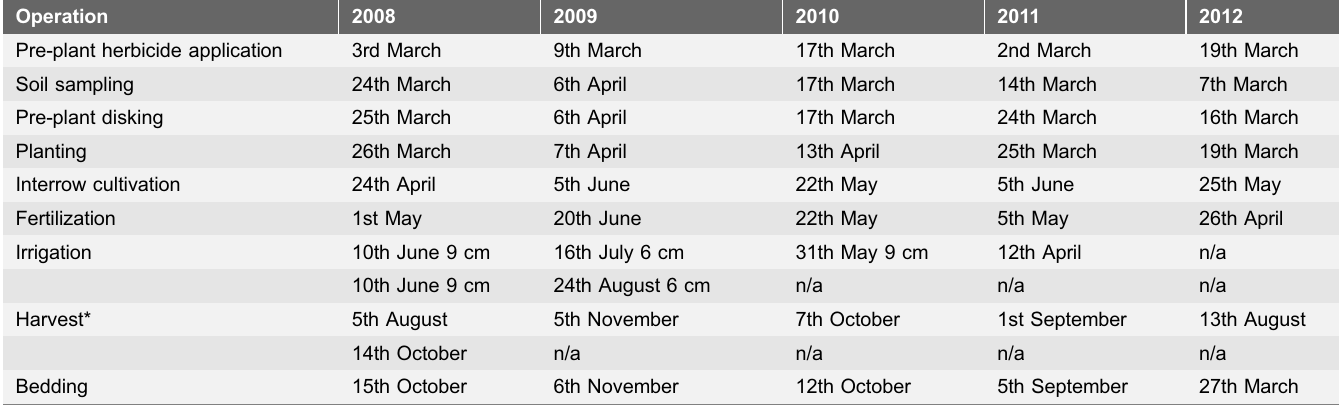
Table 1. Field operations and dates performed at College Station,